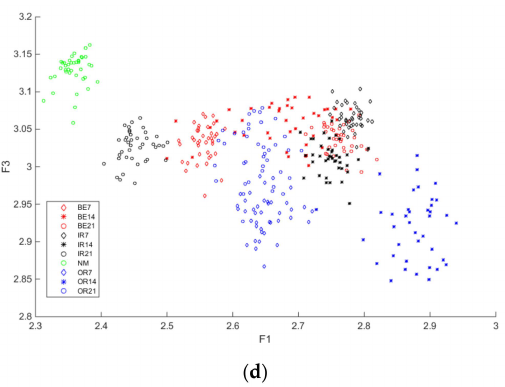
Figure 8. MAAPE feature clustering diagram of each fault severity under di ff erent loads. ( a ) Load 0 hp. ( b ) Load 1 hp. ( c ) Load 2 hp. ( d ) Load 3 hp.